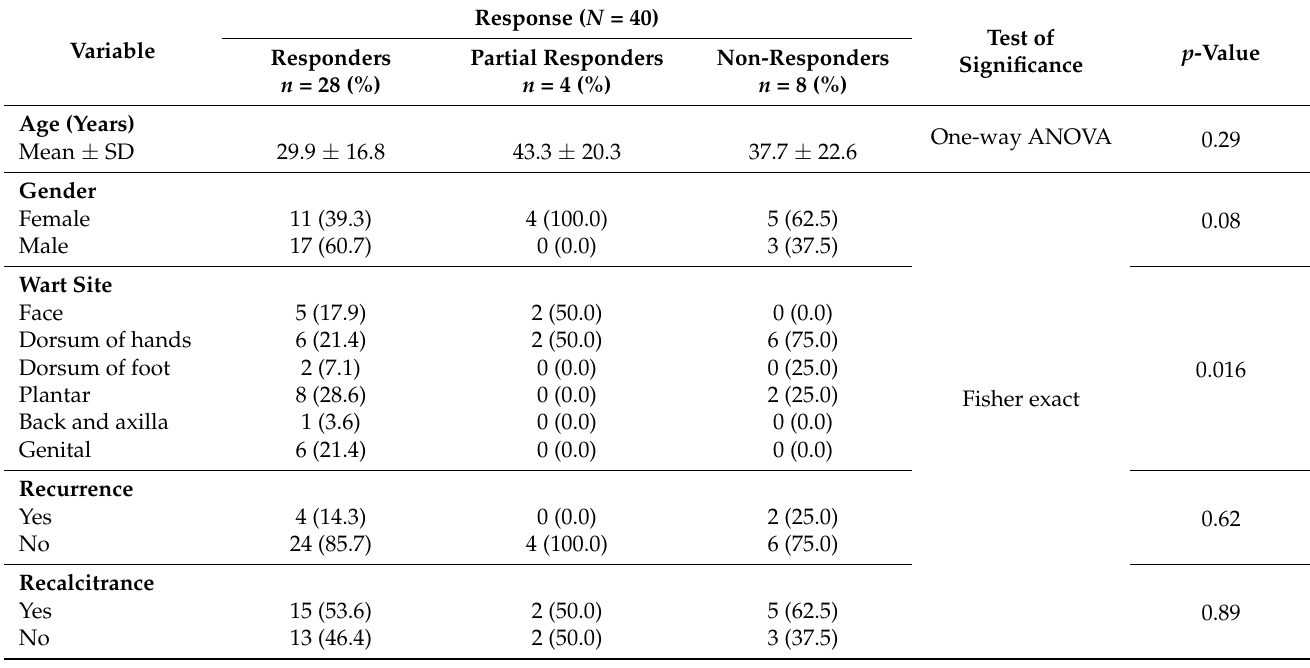
Table 3. Relation between clinical variables, in vitro cytokine response, and therapeutic response to bivalent HPV vaccine. Variable